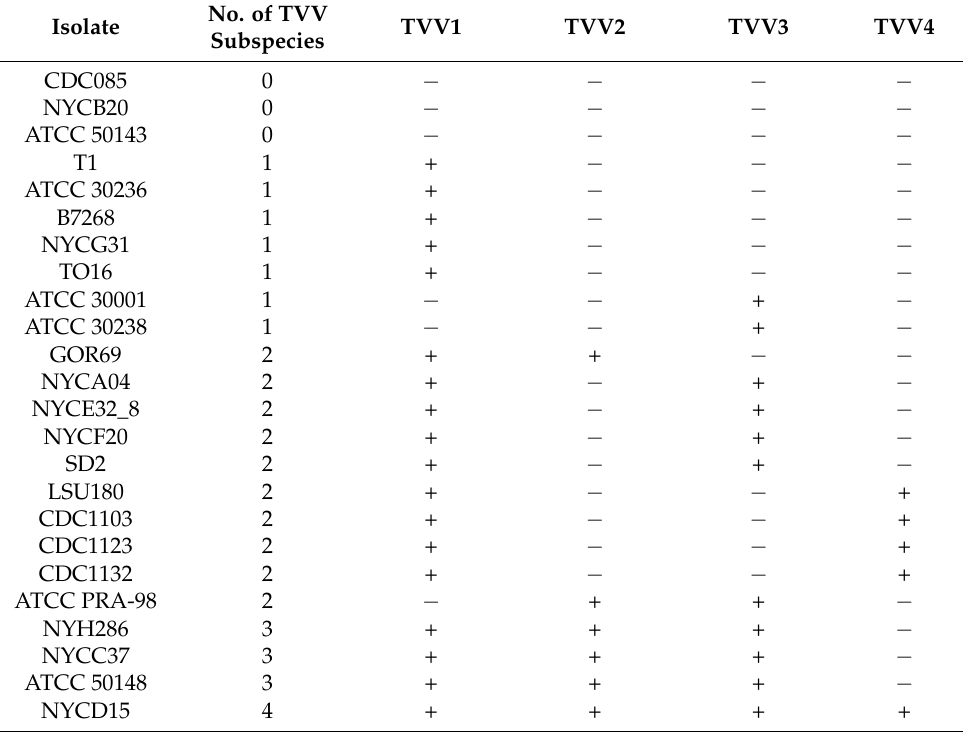
Table 3. Identification of TVV subspecies by RNA sequencing and NGS. No. of Isolate